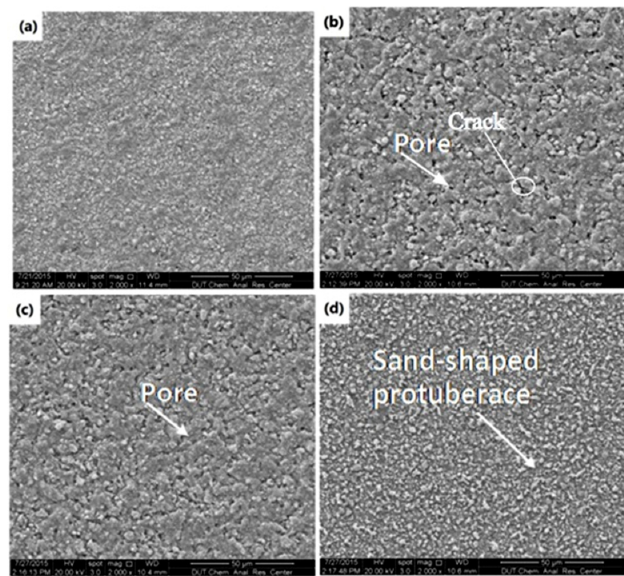
Figure 6. SEM images for four ‐ layer BTO thin film deposited with different jet heights: ( a ) 4 mm, ( b ) 5 mm, ( c ) 6 mm and ( d ) 10 mm.